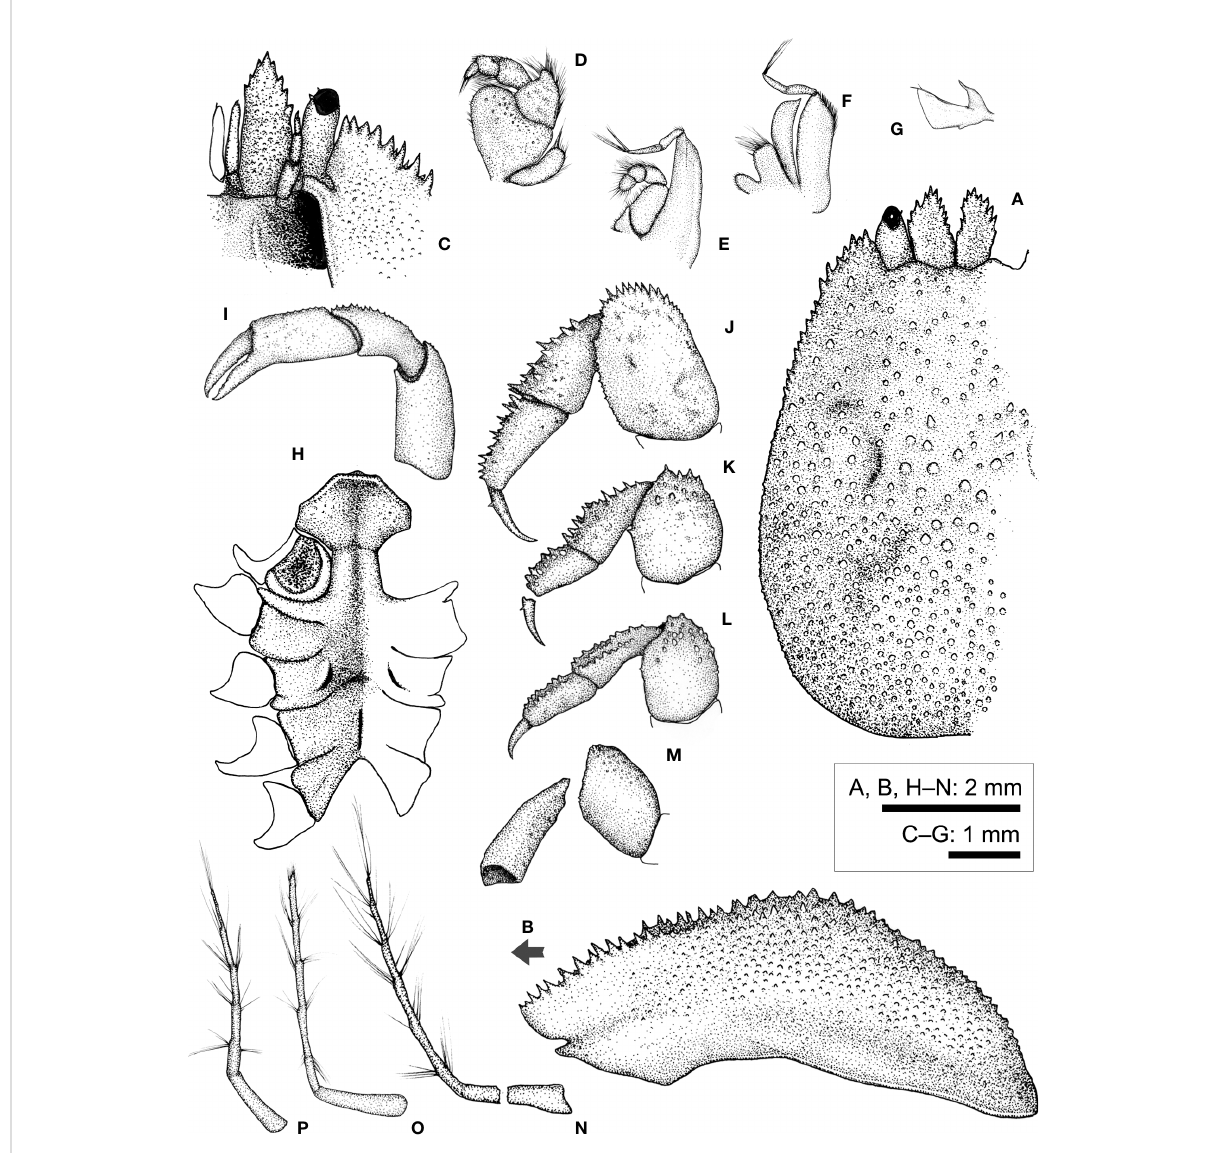
FIGURE 10 Lithoscaptus doughnut sp. nov., female (CEL-Hapa-040). (A) carapace, dorsal view; (B) carapace, lateral view; (C) anterior view of carapace, ventral view; (D) left Mxp3; (E) left Mxp2; (F) left Mxp1; (G) left Mxl 1; (H) thoracic sternites; (I) left P1; (J – M) left P2 to P5, dorsal view; (N – P) plp1 to plp3, lateral view. Arrow in (B) indicates the anterior